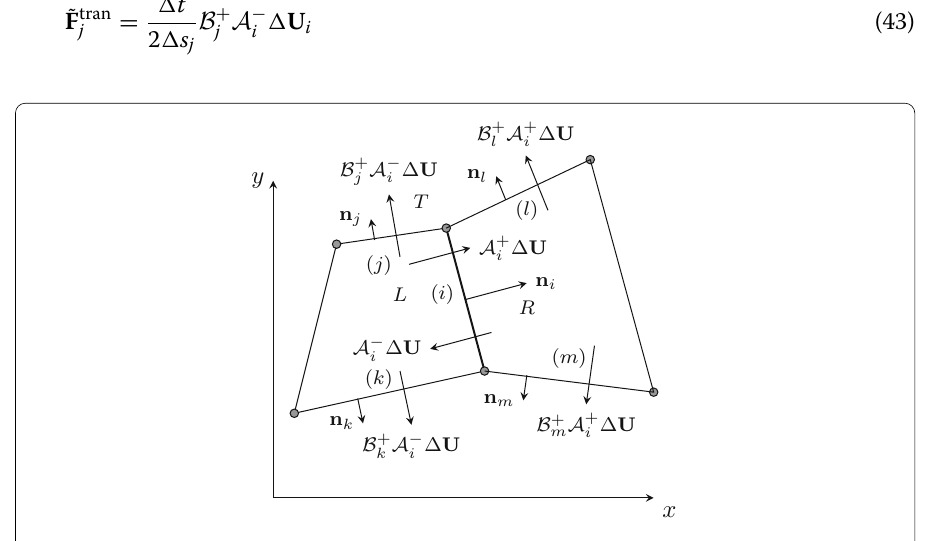
Fig. 4 Normal and transverse fluctuations defined from edge